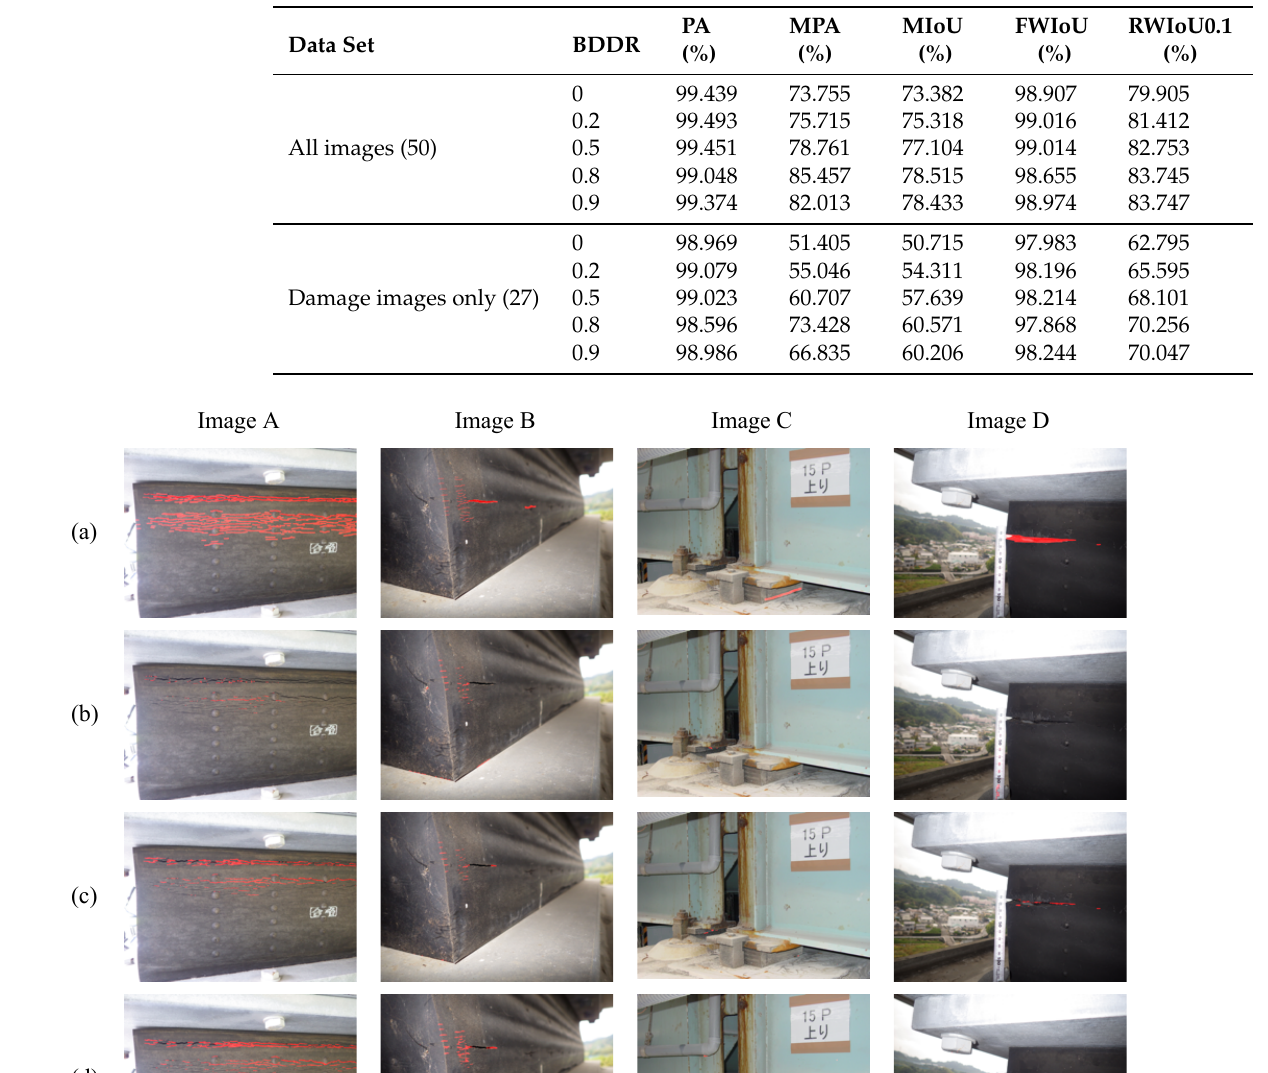
Table 6. All results of evaluation method.